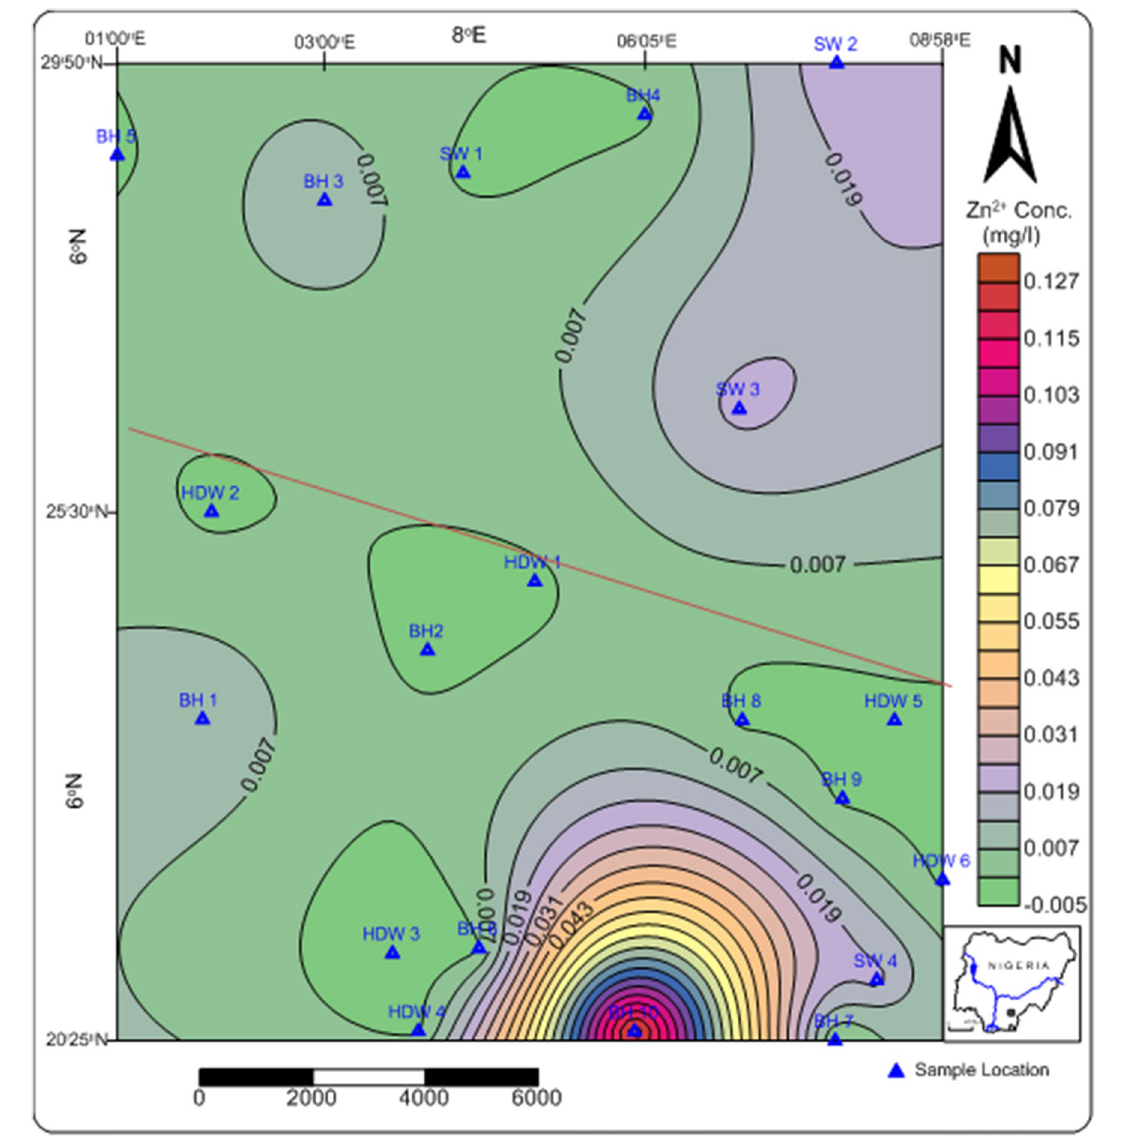
Fig. 16 Map showing dispersion of zinc. Note : Perpendicular line indicates groundwater